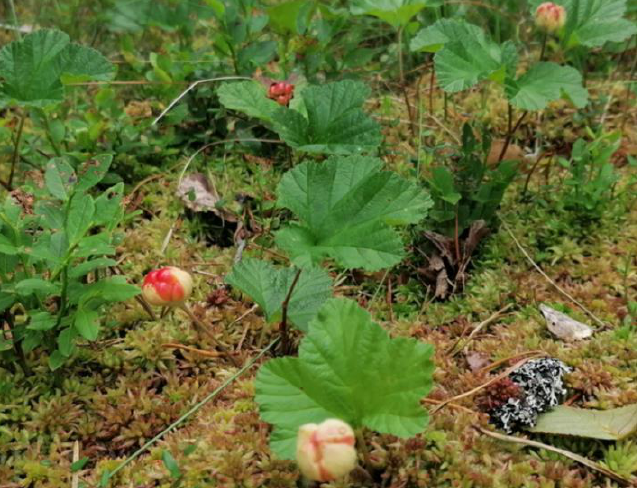
Figure 6. Wild cloudberry with visibly red (unripe) fruits (photo by L. Āboliņa, 6 July 2020, Latvia).